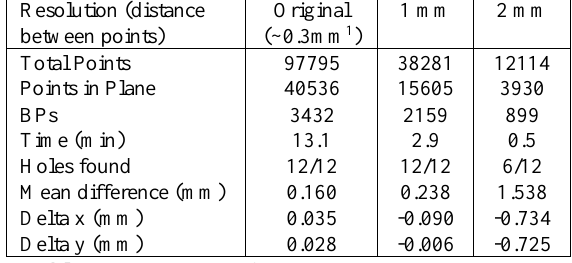
Table 1: Sample results from two combined oblique scans 1 Approximate value, laser spot size is not given on manufacturer’s technical sheet.